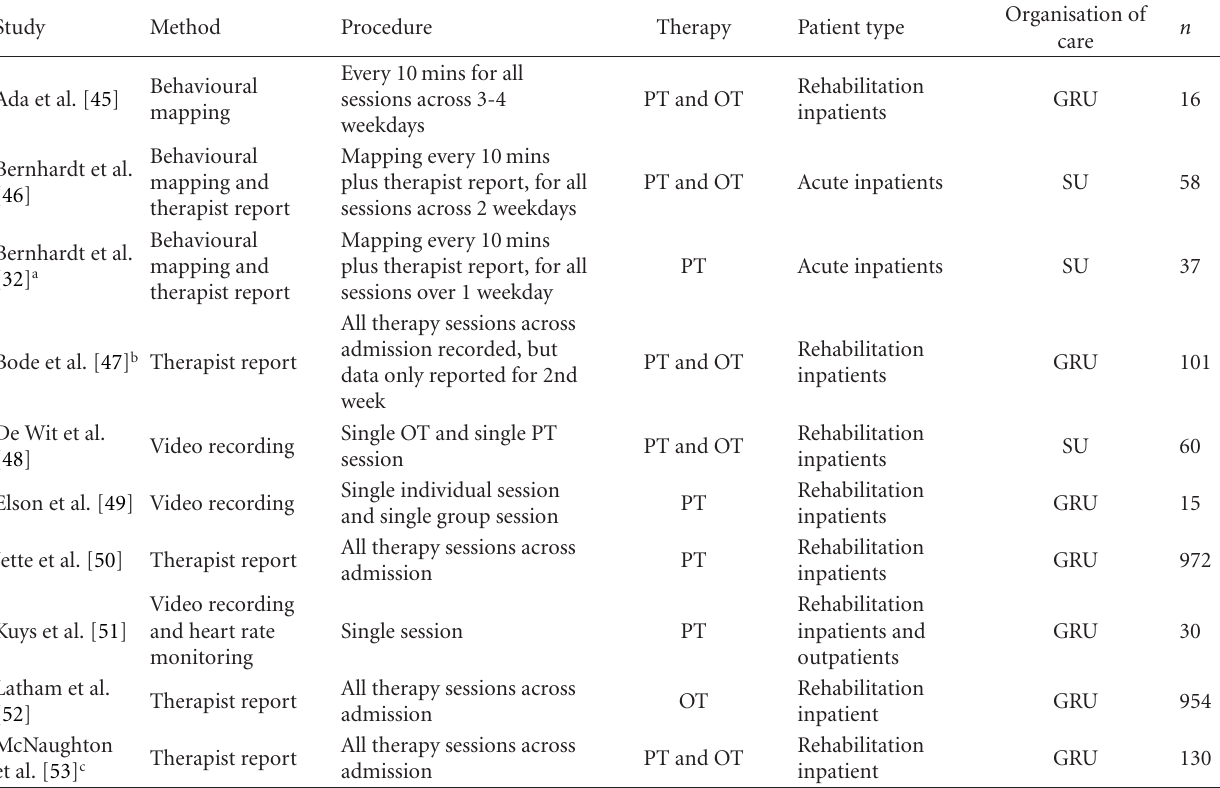
Table 3: Therapy-specific activity